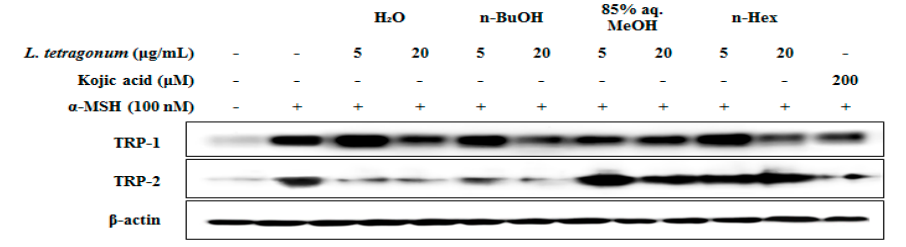
Figure 4. Changes in protein levels of TRP-1, and TRP-2 in L. tetragonum solvent-partitioned fractions and Kojic acid treated B16-F10 cells.